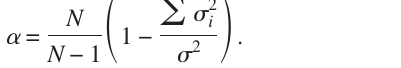
Table I lists semester test reliability coefficients along with their predicted exam score uncertainty for the three methods of splitting the exam questions (cid:1) A+ to C−-students only (cid:2) . 17